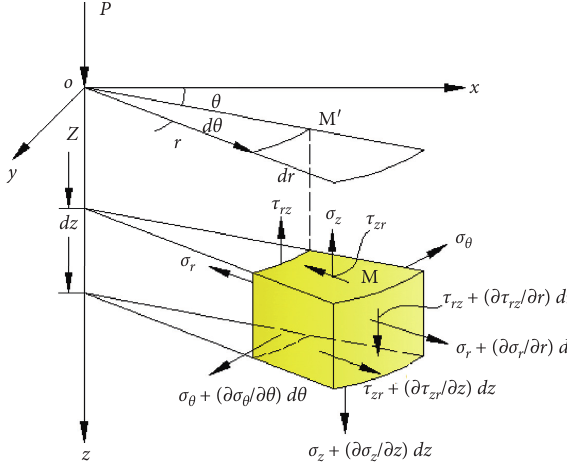
Figure 2: Stresses in a rock unit.